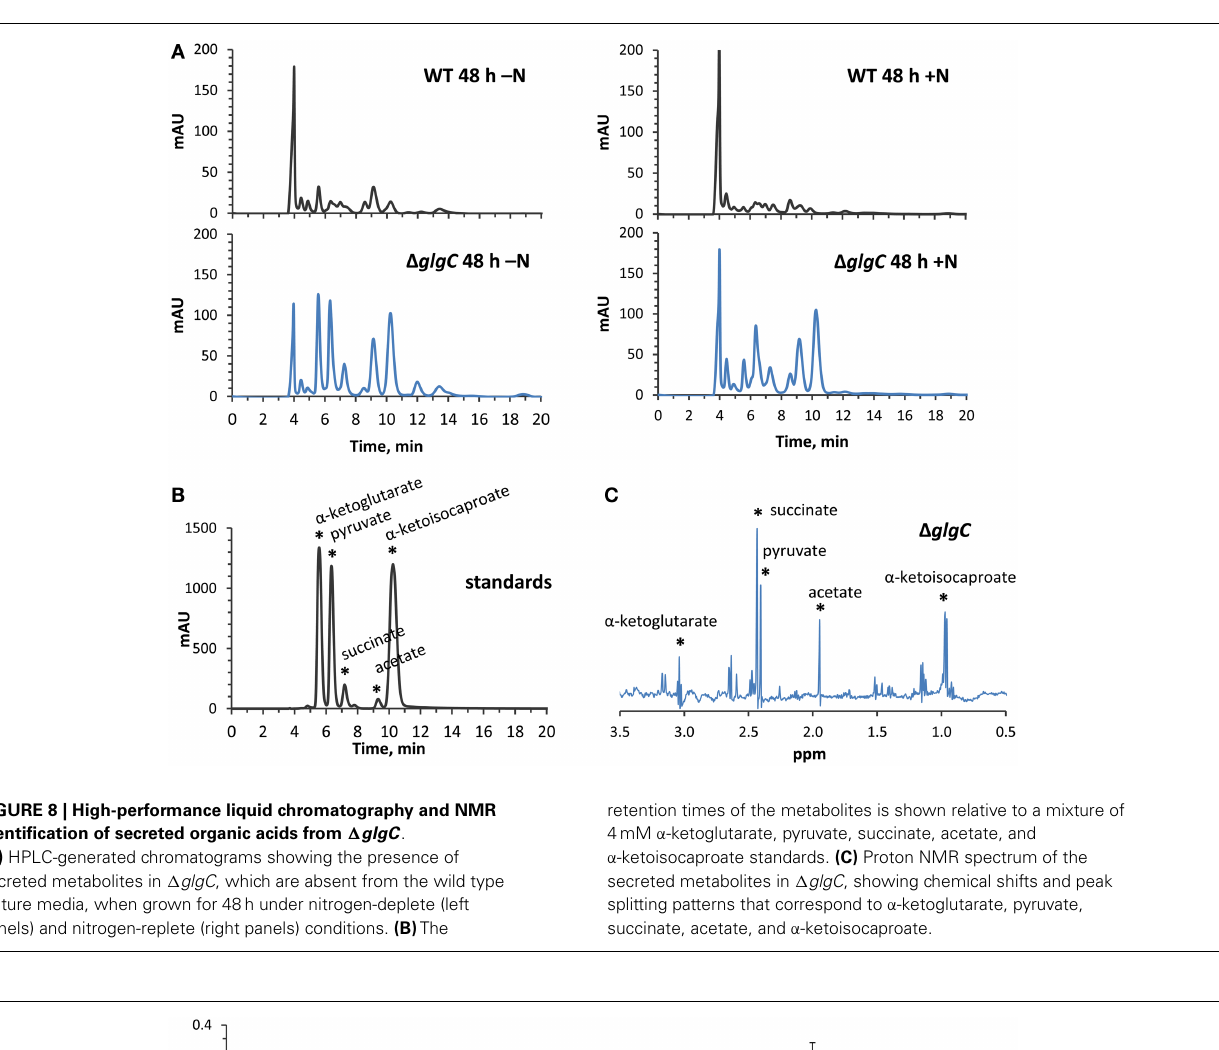
FIGURE 8 | High-performance liquid chromatography and NMR identification of secreted organic acids from ∆ glgC . (A) HPLC-generated chromatograms showing the presence of secreted metabolites in ∆ glgC , which are absent from the wild type culture media, when grown for 48h under nitrogen-deplete (left panels) and nitrogen-replete (right panels) conditions. (B) The